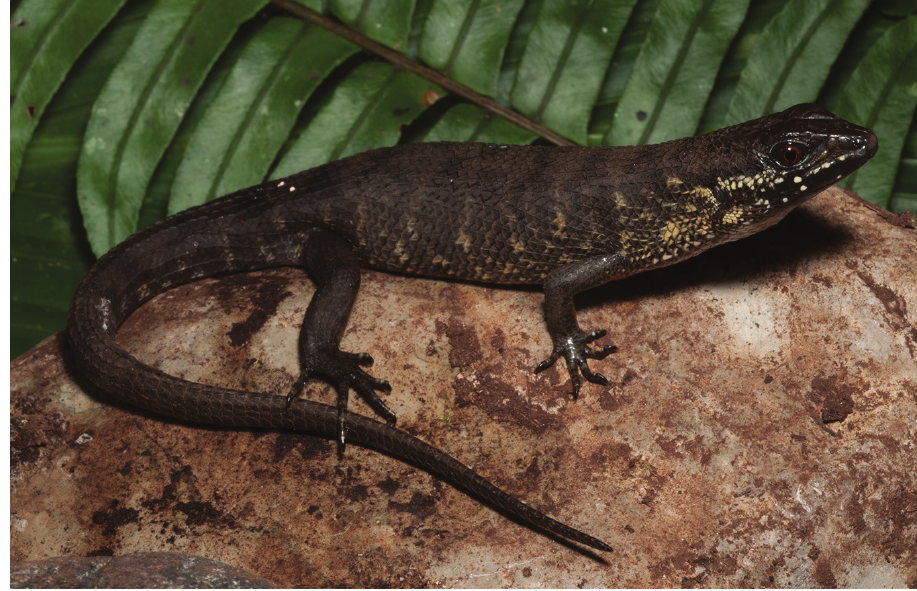
Figure 62. Tropidophorus misaminius male (KU 334249) from Mt. Hilong-hilong, Municipality of Re- medios T. Romualdez, Agusan del Norte Province. Photo: